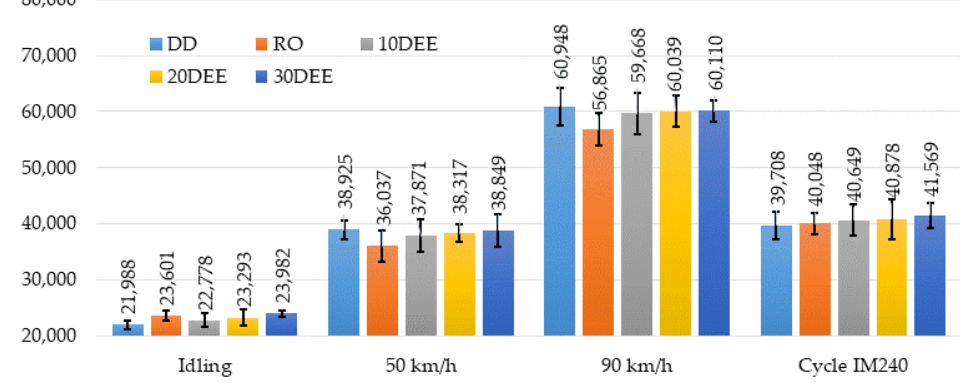
Figure 6. CO 2 emissions of DD, RO, 10DEE, 20DEE and 30DEE in different testing conditions.